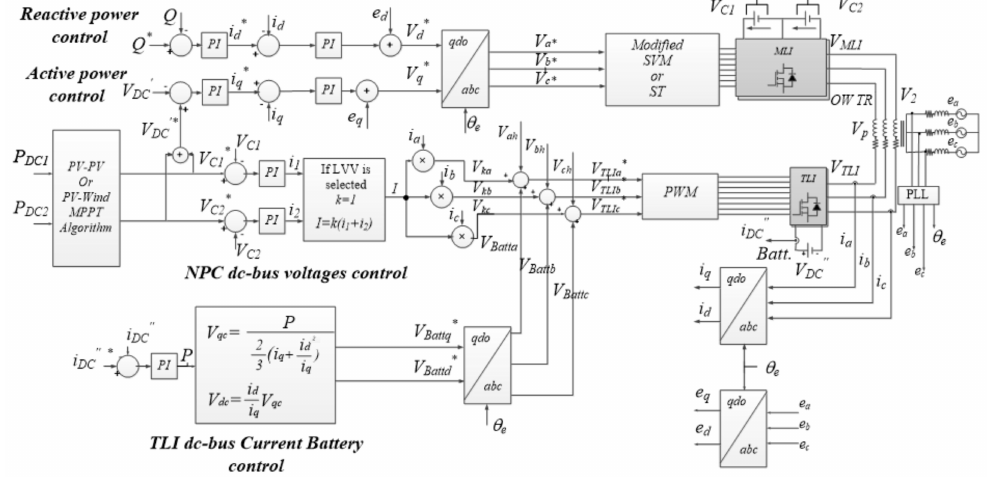
Figure 9. Six-level MMC (3LI + TLI).